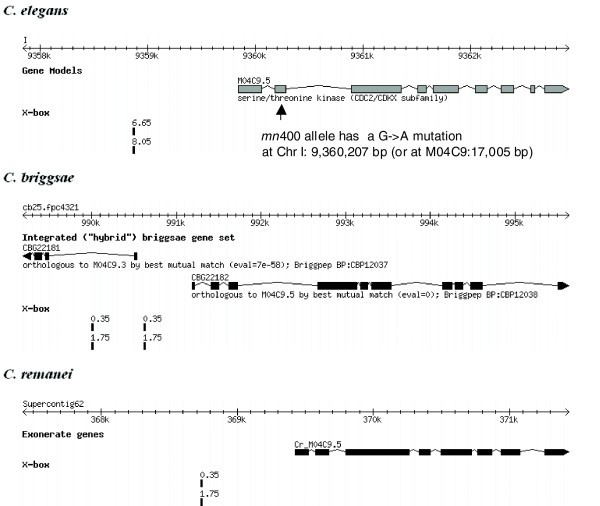
Identification of X-box regulated genes facilitated the cloning of the C. elegans dye filling defective gene, dyf-5. M04C9.5 in C. elegans and its orthologs in C. briggsae (CBG22182) and C. remanei (Cr_M04C9.5) all have X-box motifs in their promoters. The C. elegans candidate gene M04C9.5 matches the genetic position of dyf-5. Sequencing of M04C9.5 in the dyf-5 strain revealed that it carries a G→A point mutation in its second coding exon, which generates a nonsense mutation and, therefore, causes a premature termination in translation. Numbers next to X-box motifs are their HMM scores. This figure was drawn using the Generic Genome Browser [49].